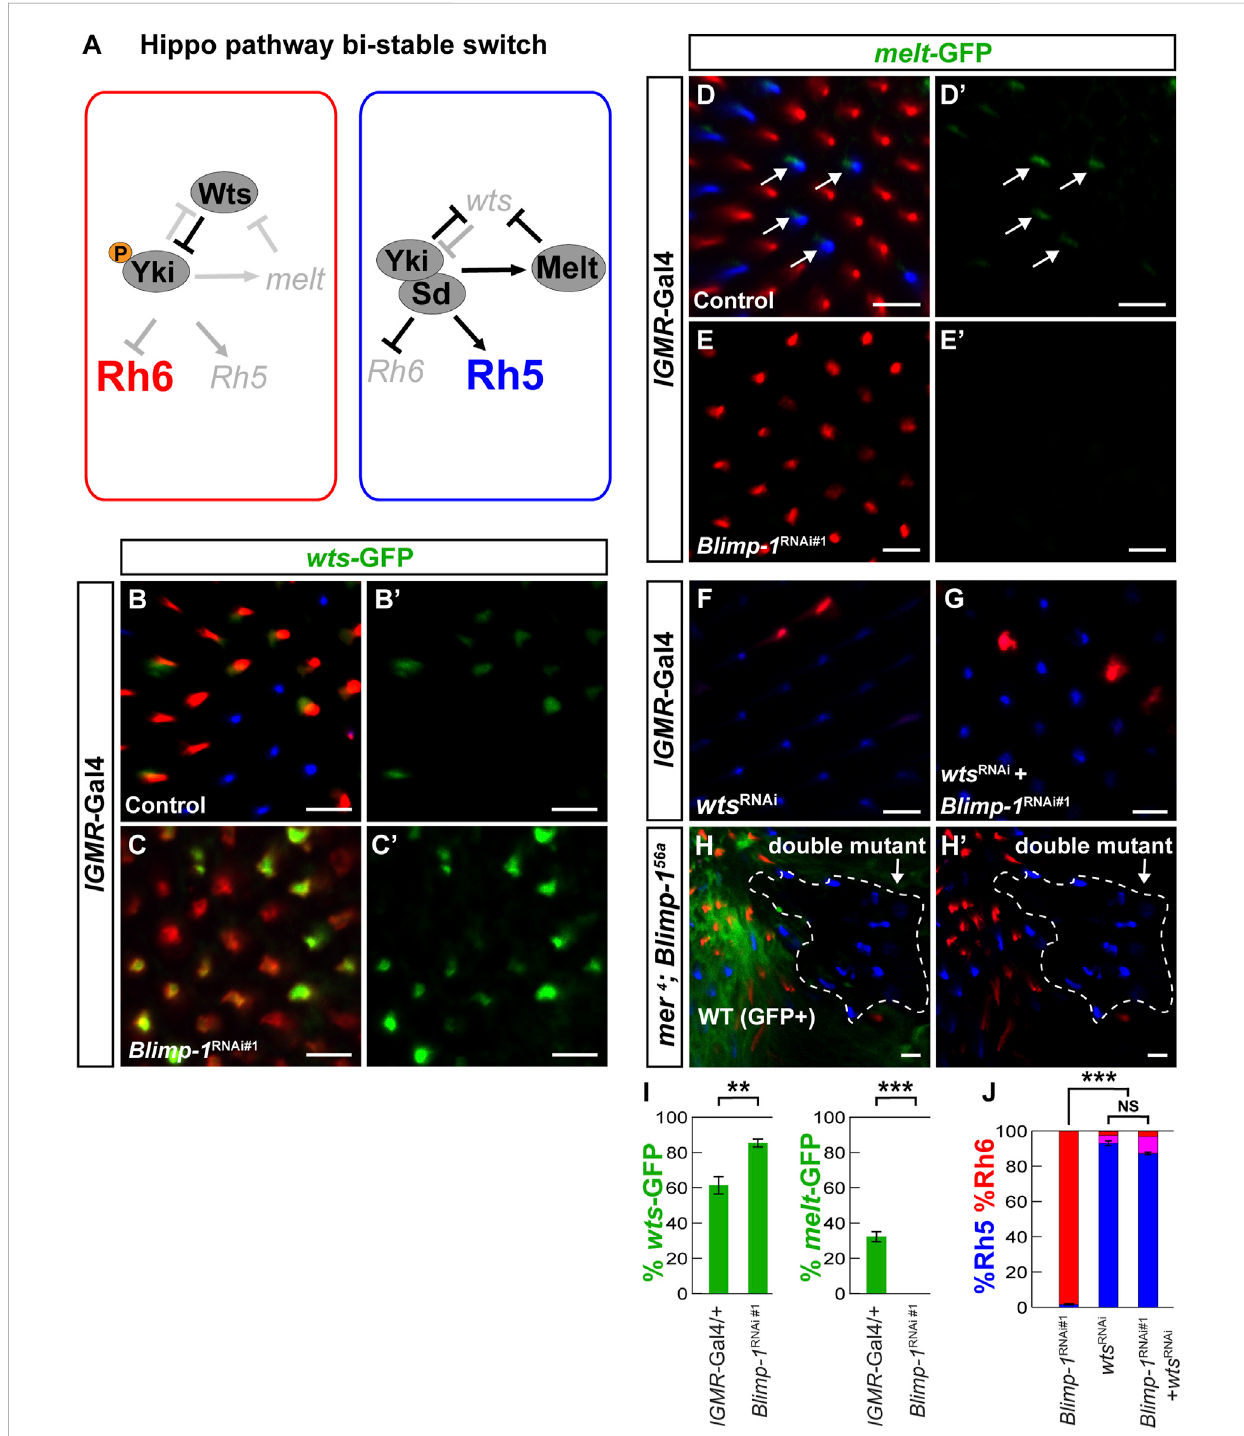
FIGURE 2 Blimp-1 is required for warts repression and melted expression. (A) Schematic of the repurposed Hippo pathway that controls a binary Rh5 vs. Rh6 cell fate decision in post-mitotic R8 photoreceptors. In Rh6 expressing photoreceptors (left), Wts represses Yki by phosphorylation, which prevents the expression of melt and Rh5 and permits Rh6 expression. In Rh5 expressing photoreceptors (right), Yki binds to Sd, activates melt and Rh5 , and represses wts and Rh6. (B) In the lGMR-Gal4 /+ driver control, the wts- GFP reporter is expressed in most Rh6 photoreceptors and absent in all Rh5 photoreceptors. (C) In lGMR > Blimp-1 RNAi#1 retinas, wts- GFP is de-repressed with Rh6. (B 9 ,C 9 ) GFP channel. (D) In the lGMR-Gal4 /+ driver control, the melt- GFP reporter is expressed in most Rh5 photoreceptors but absent in Rh6 photoreceptors. White arrows indicate melt- GFP expression. (E) In lGMR > Blimp-1 RNAi#1 retinas, melt- GFP expression is completely lost. (D 9 , E 9 ) GFP channels. (F) Knockdown of wts with lGMR-Gal4 causes a gain of Rh5 and loss of Rh6. (G) Knockdown of Blimp-1 in addition to wts does not modify the wts knockdown phenotype. (H) mer 4 ; Blimp-1 56a double mutant clones (encircled by the white dashed line) exclusively express Rh5, which is the opposite of Blimp-1 56a mutant clones that exclusively express Rh6. All